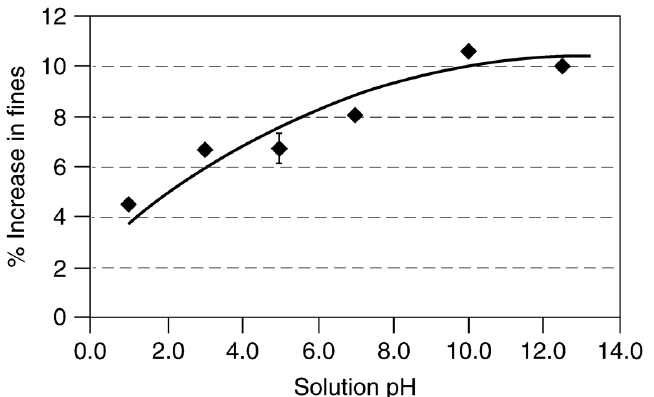
Figure 35. Effect of solution pH on the attrition resistance of 70-μm γ-Al 2 O 3 particles measured in jet-cup tests [235]. The % increase in fines is defined at the % increase of particles of less than 11